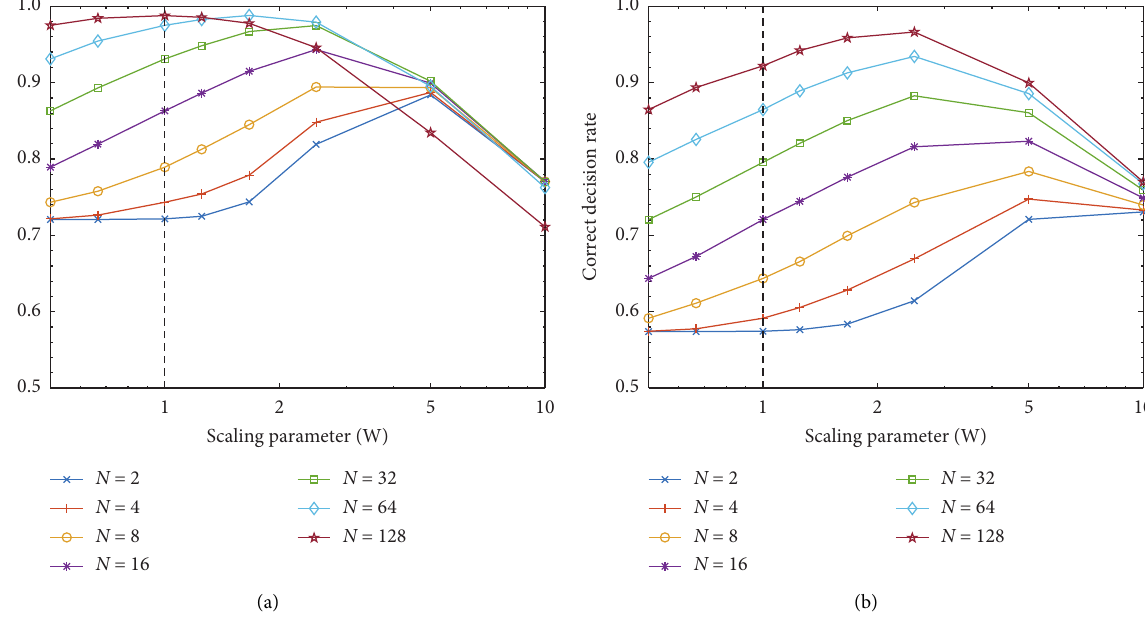
� 0 . 4 , P � 0 . 5; (b) P A B